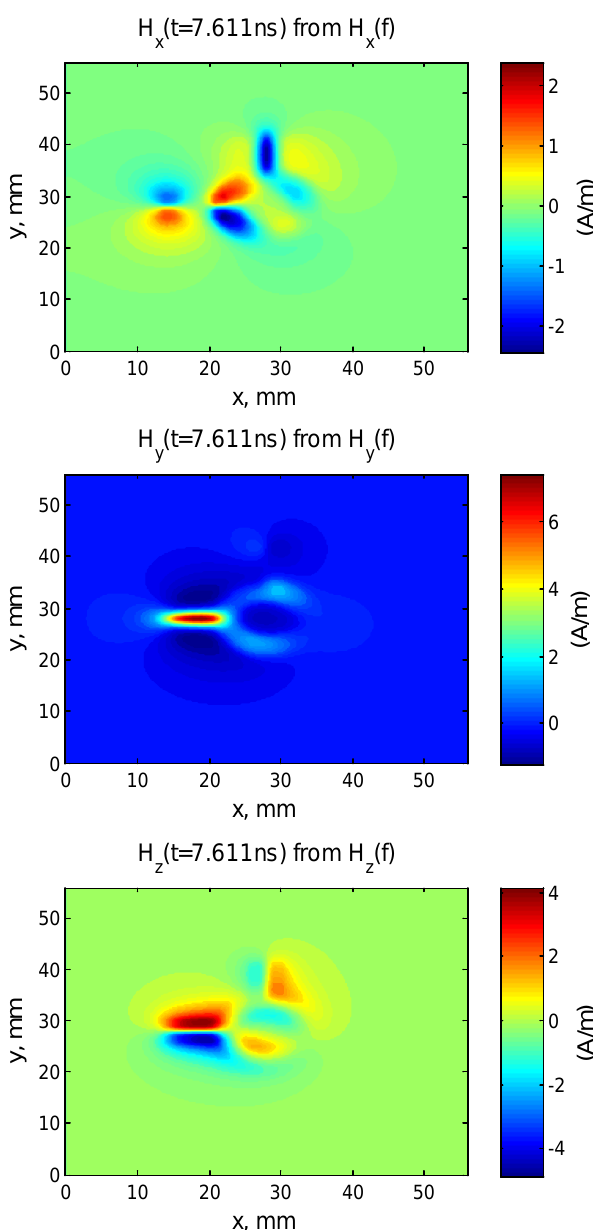
Figure 9: C artographies o f magnetic f ield components: obtained f rom t he pr oposed t ime-frequency c omputation